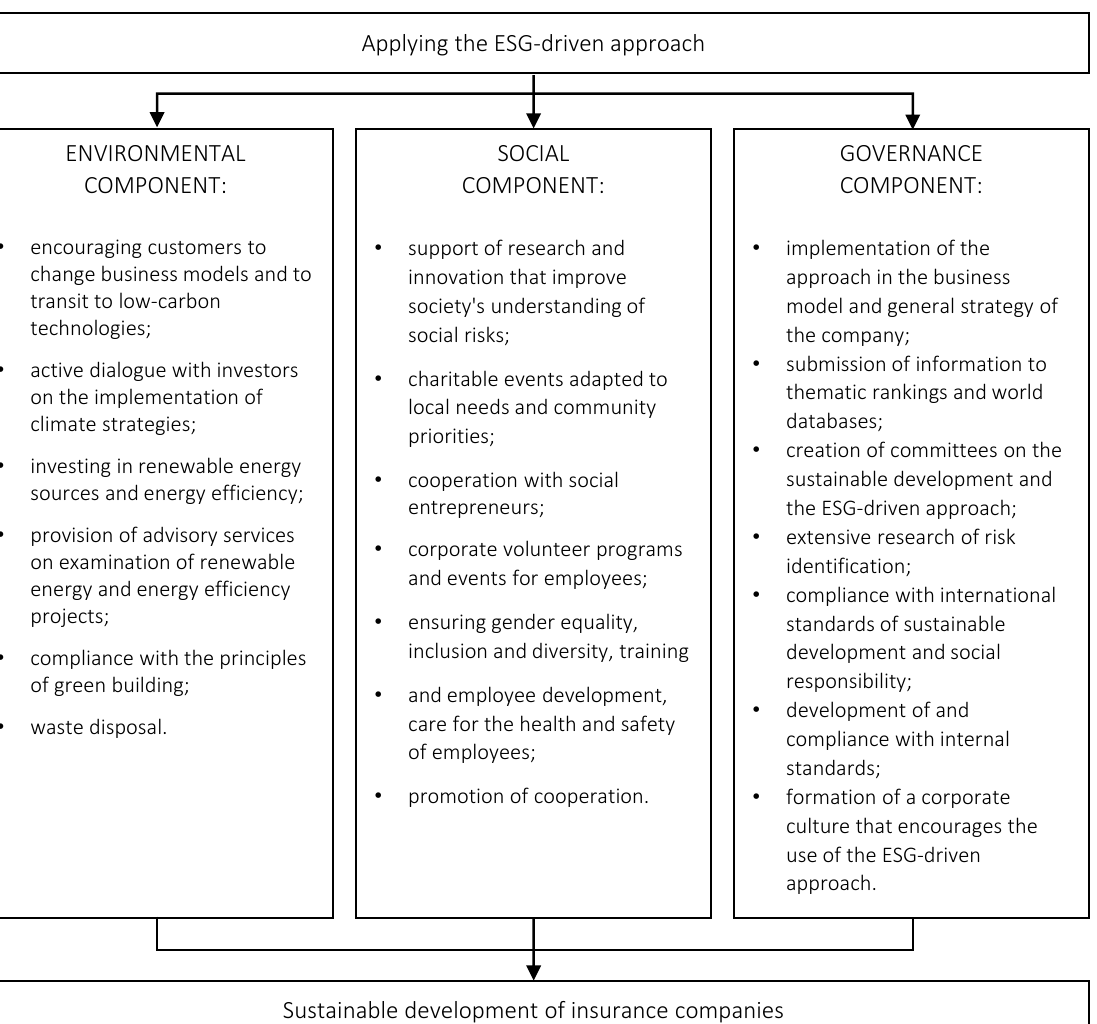
Figure 4. Best practices of insurance companies for applying the ESG-driven approach to